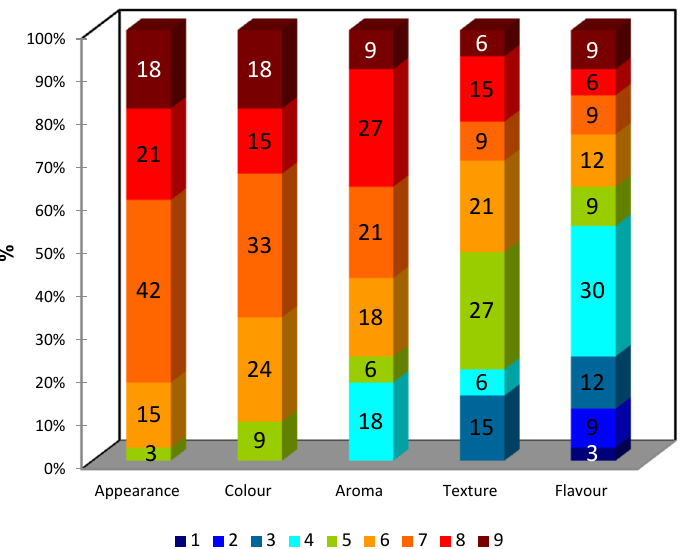
Figure 3. Percentages (values in coloured bars) for liking intensity scores (9-point hedonic scale) for overall appearance, colour, aroma, texture and flavour obtained from consumer tasting.